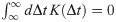
Relationship between periodic patterning and receptive field refinement.
A. Example of RF refinement obtained by numerically solving Eq 6. Vertical teal lines denote the arbor function boundary. B. Refinement phase space for RFs as a function of wave speed and STDP time constants. Colored regions: areas of phase space in which RFs maintain a single field that is refined to smaller sizes; blue: RF
0 = 0.8 mm; purple: RF
0 = 0.44 mm. Shading indicates the total change in RF size as a percentage of RF
0. Region α corresponds to higher spatial frequencies in which RFs split into subfields. Region β corresponds to lower spatial frequencies in which RFs expand. Overlaid are the iso-frequency contours of Fig 3. Solid contours correspond to spatial frequencies with integer exponents of 10 (lower left to upper right: 10 cyc./mm, 1 cyc./mm and 0.1 cyc./mm). C. Incremental changes in wave speed can continually refine RFs while maintaining a single subfield structure. Shown is the development of a RF, averaged over 16 trials, during which the wave speed is first set to 4 mm/s and then decreases to 2.5 mm/s, after which the RF decreases in size. Increasing the wave speed back to 4 mm/s returns the RF to its previous refined size. Purple trace: plot of the mean number of synapses with strength > 0.5 as an indicator of RF size. D. Refinement phase space using a symmetric STDP rule, for which RF
0 matches that for the blue region in B. Numbers next to the iso-frequency contours indicate their spatial frequency in cycles/mm. E. Refinement phase spaces, using the asymmetric STDP rule, for different biases towards synaptic weakening. Left: A
− = 0.50, which corresponds to ∫∞∞dΔtK(Δt)=0. Centre and right: A
− = 0.55 and 0.60, respectively, which correspond to ∫∞∞dΔtK(Δt)>0. Red circles lie at the same v and τ
+ coordinates, to compare the effect of different A
− values on RF refinement. The refinement phase space moves to lower spatial frequencies as A
− increases.